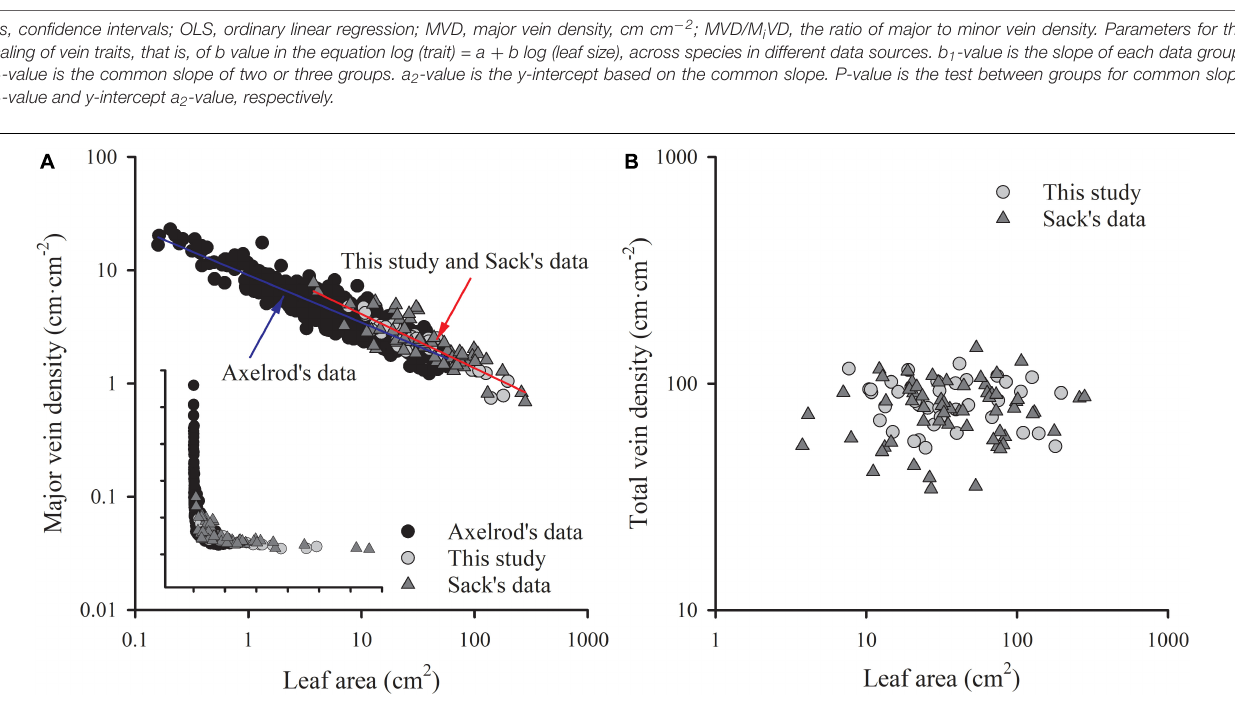
definition of ours, the scaling exponent was still